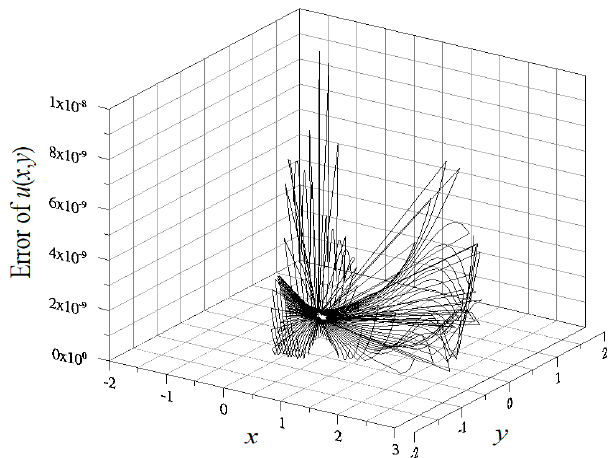
Figure 9. The numerical errors of the proposed method solution for the steady-state AC equation with amoeba-like irregular domain.